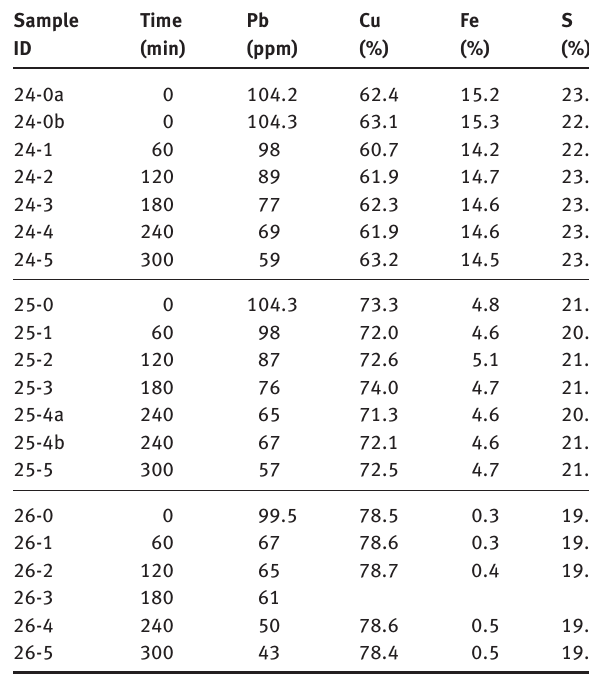
Table 3: Chemistry of the matte from the matte grade experiments